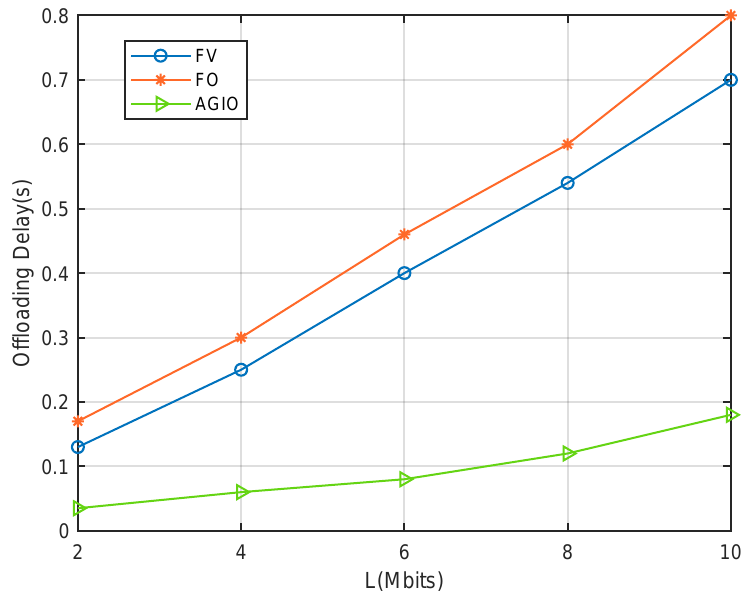
Figure 6. Comparison of offloading delay with different computation task size